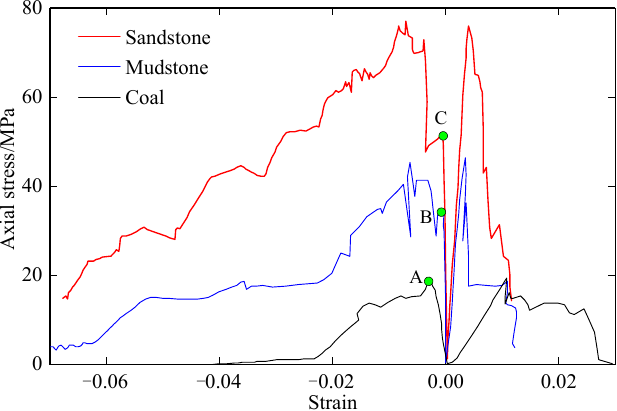
Figure 5. Rock specimens before and after uniaxial compression test. ( a ) Intact specimens; ( b ) failure modes.